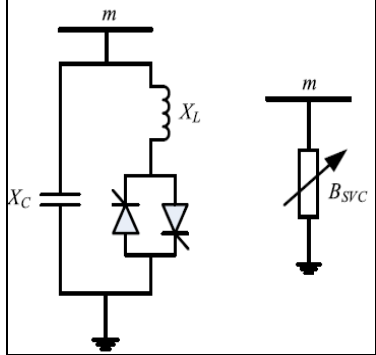
Figure 6. Basic structure and model of SVC [23].